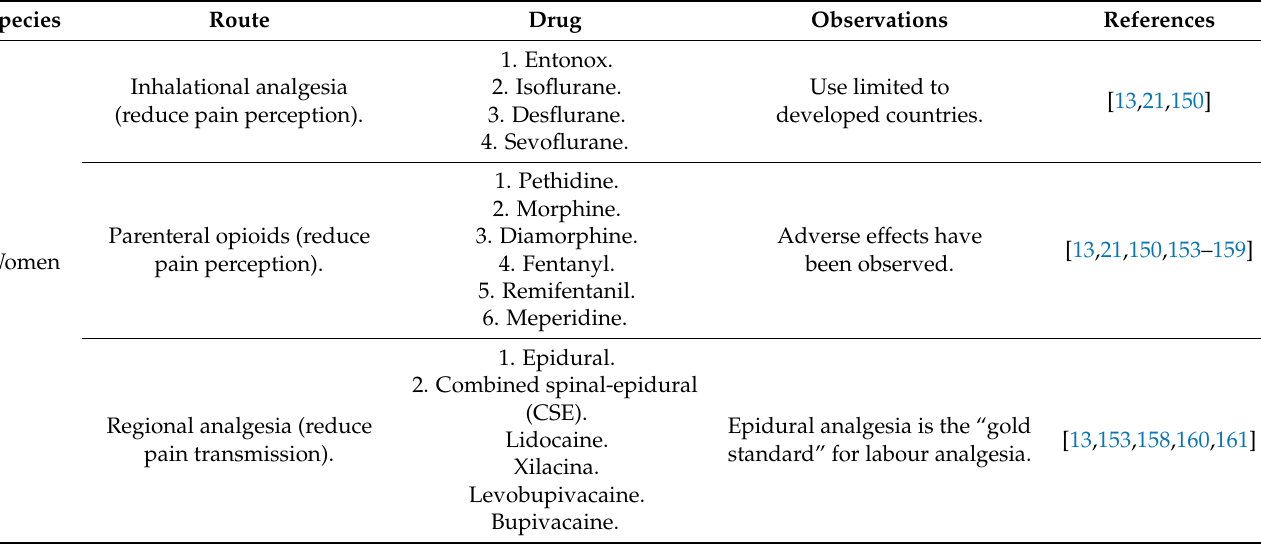
Table 6. Pharmacological analgesia for labour pain in humans and domestic animals. Species